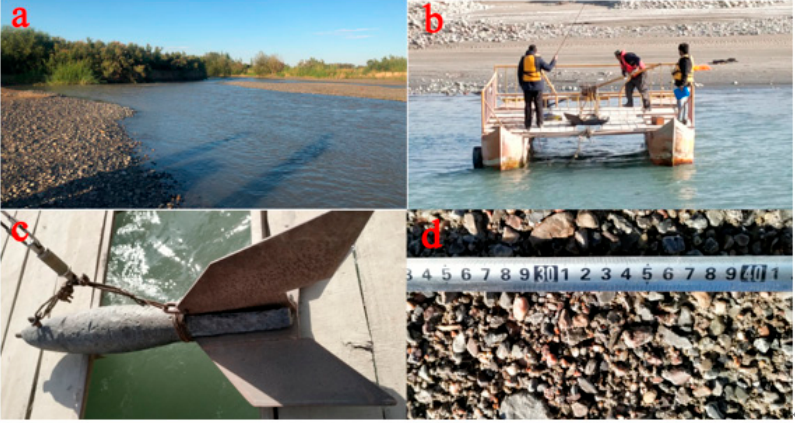
Figure 4. In situ experiment: ( a ) representative river landscape in the study area; ( b ) workers measuring the depth and velocity of the water in a survey boat; ( c ) the lead fish used; ( d ) changes in pebble particle size along the riverbank.